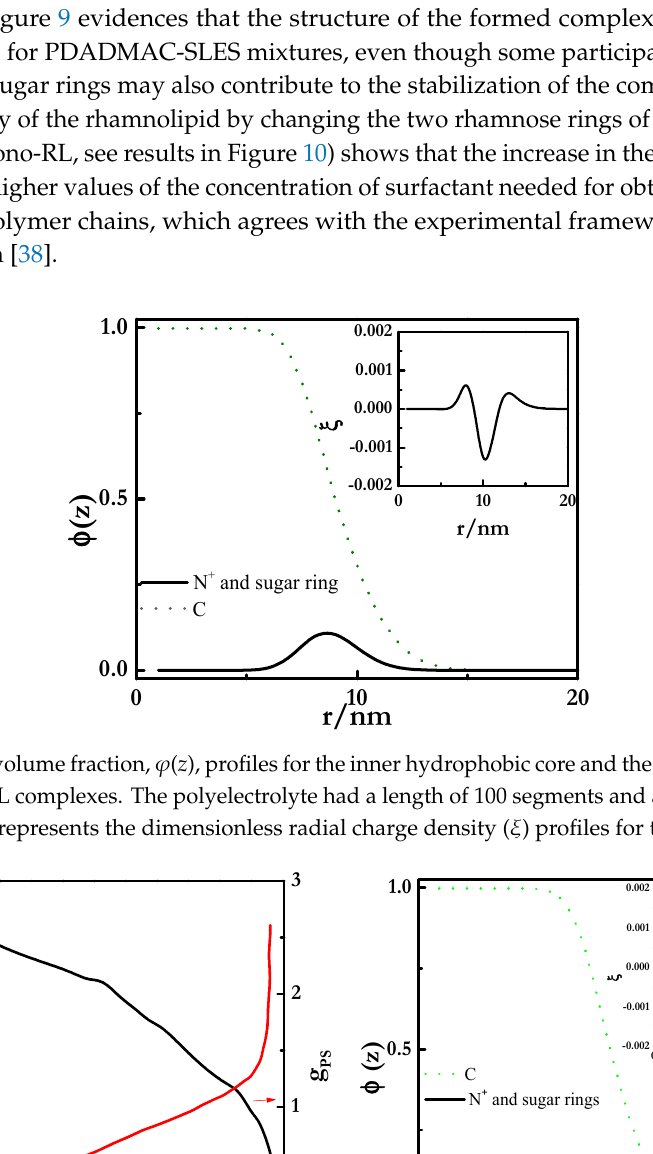
Figure 10. ( a ) Dependences of the aggregation number of surfactants in the complexes ( g s , left axis) and the degree of polyelectrolyte–surfactant binding ( g PS , right axis) on the chemical potential of the polymer µ P for mixtures of PDADMAC with mono-RL. ( b ) Radial volume fraction ( hydrophobic core and the charged corona of PDADMAC-mono-RL complexes. The polyelectrolyte had a length of 100 segments and a segment valence ν p = 1. The inset represents the dimensionless radial charge density ( ξ ) profiles for the